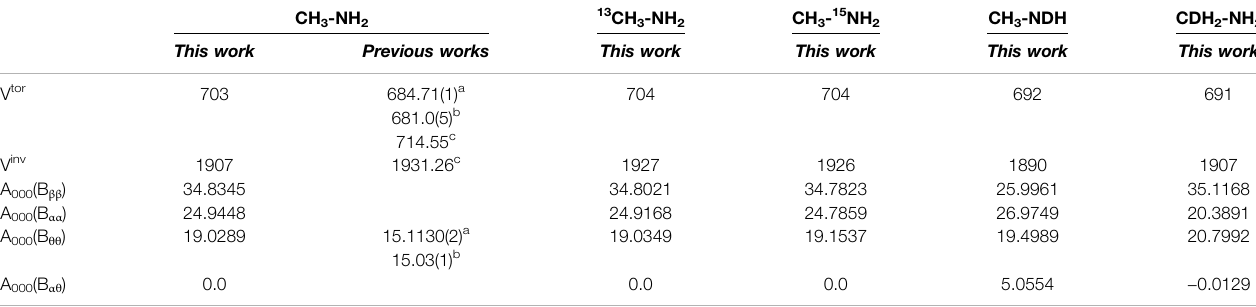
TABLE 4 | CCSD(T)-F12/AVTZ potential energy barriers (in cm − 1 ).